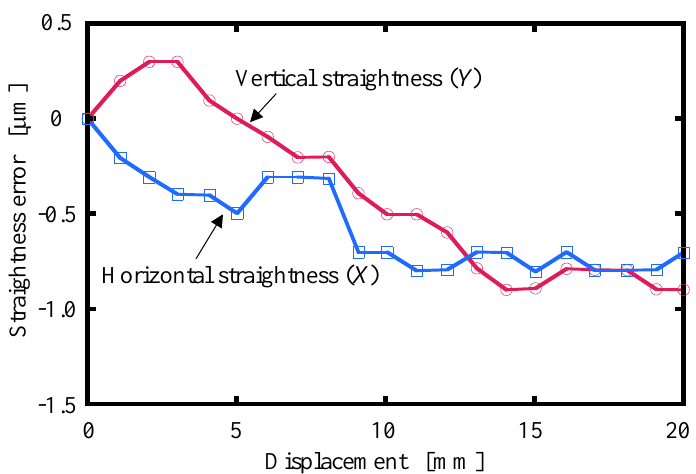
Figure 11. Straightness error of the commercial nanopositioning and nanomesuring machine (NMM- 1).